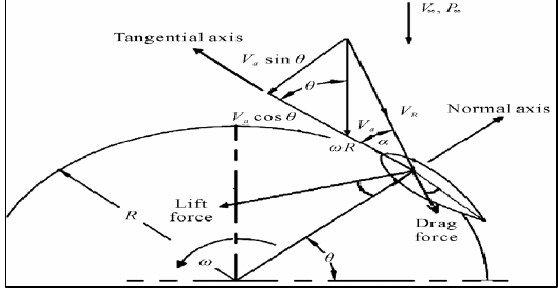
Figure 2. Airfoil velocity and force diagram